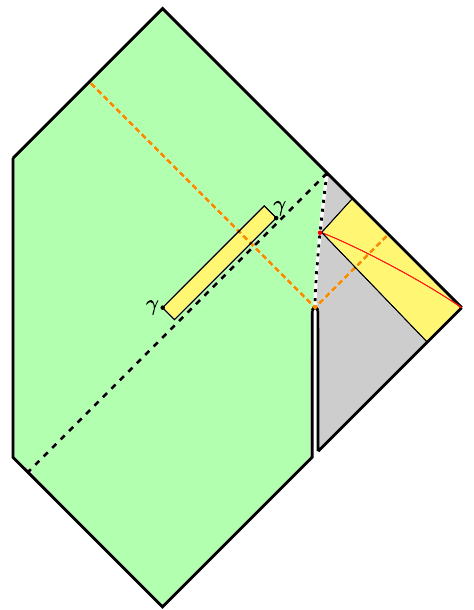
Figure 2 . The new quantum extremal surface γ of [13, 14] for an evaporating JT wormhole. The entanglement wedge of the reservoir at the boundary time indicated by the red dot is shaded yellow, note in particular the island in the gravitational